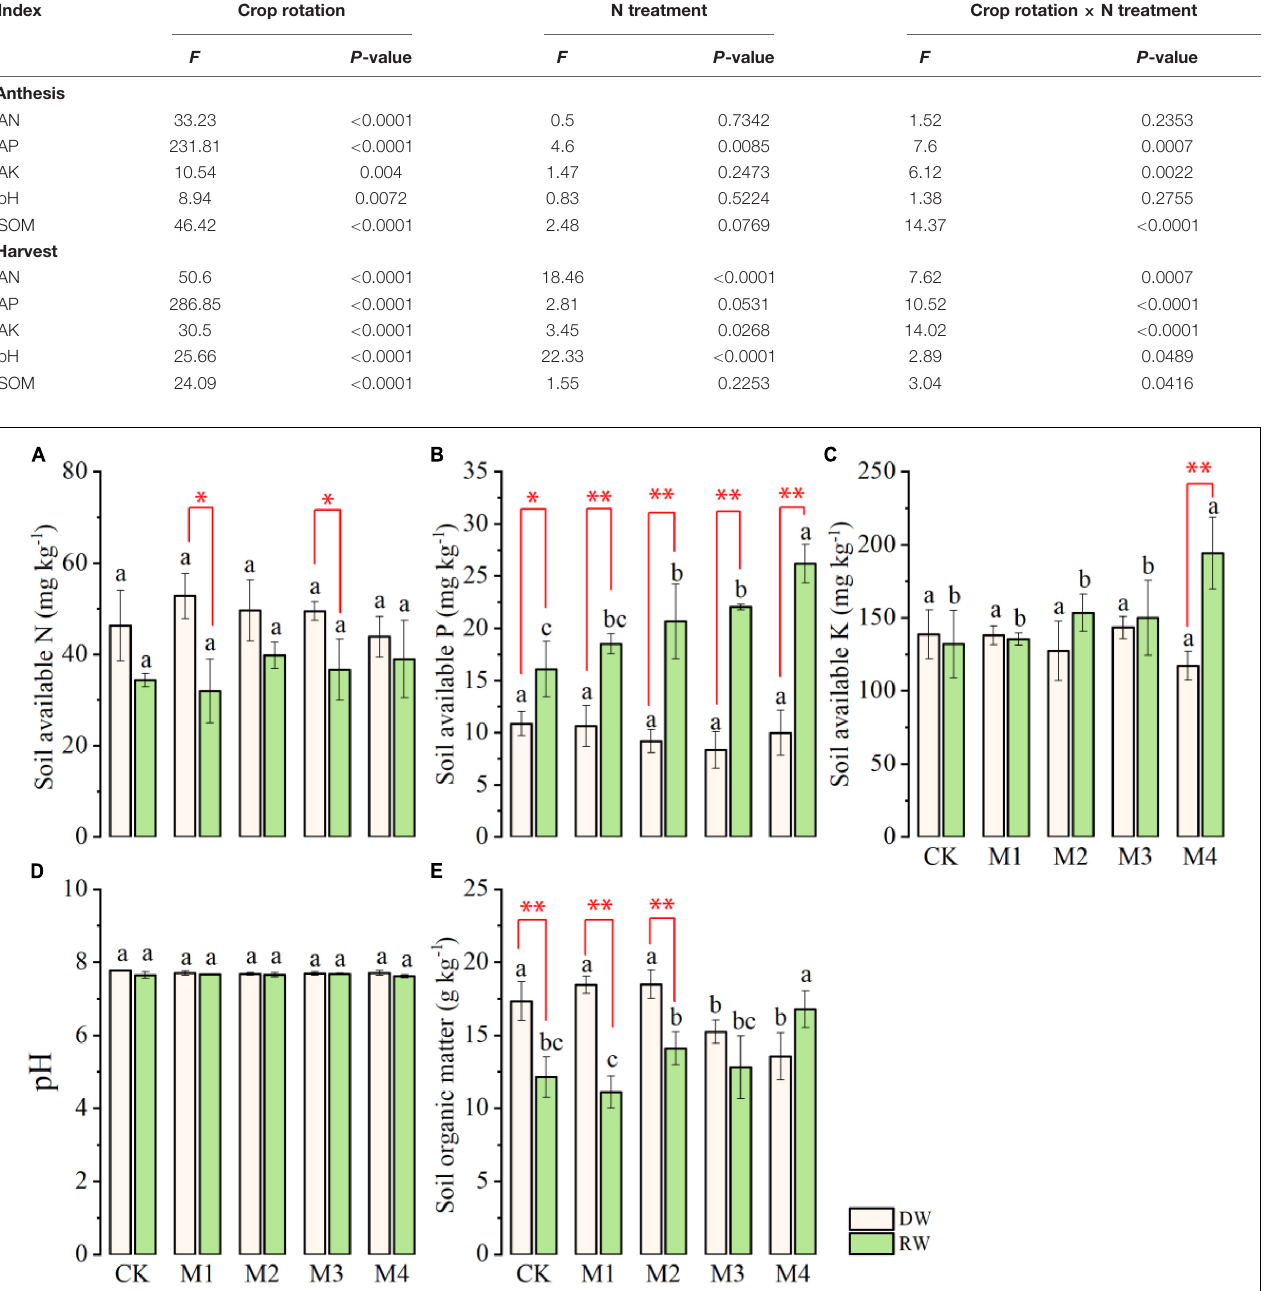
FIGURE 4 | Soil chemical properties ( A , available nitrogen, AN; B , available phosphorus, AP; C , available potassium, AK; D , pH; E , organic matter, SOM) at anthesis stage under dryland crop–wheat (DW) and rice–wheat (RW) cropping systems under different N treatments. The different lower-case letters in the same crop rotation indicate significant differences ( p < 0.05) among the N treatment. The symbols ∗ , ∗∗ indicate significance at p < 0.05, 0.01 between DW vs. RW, respectively; blank is not